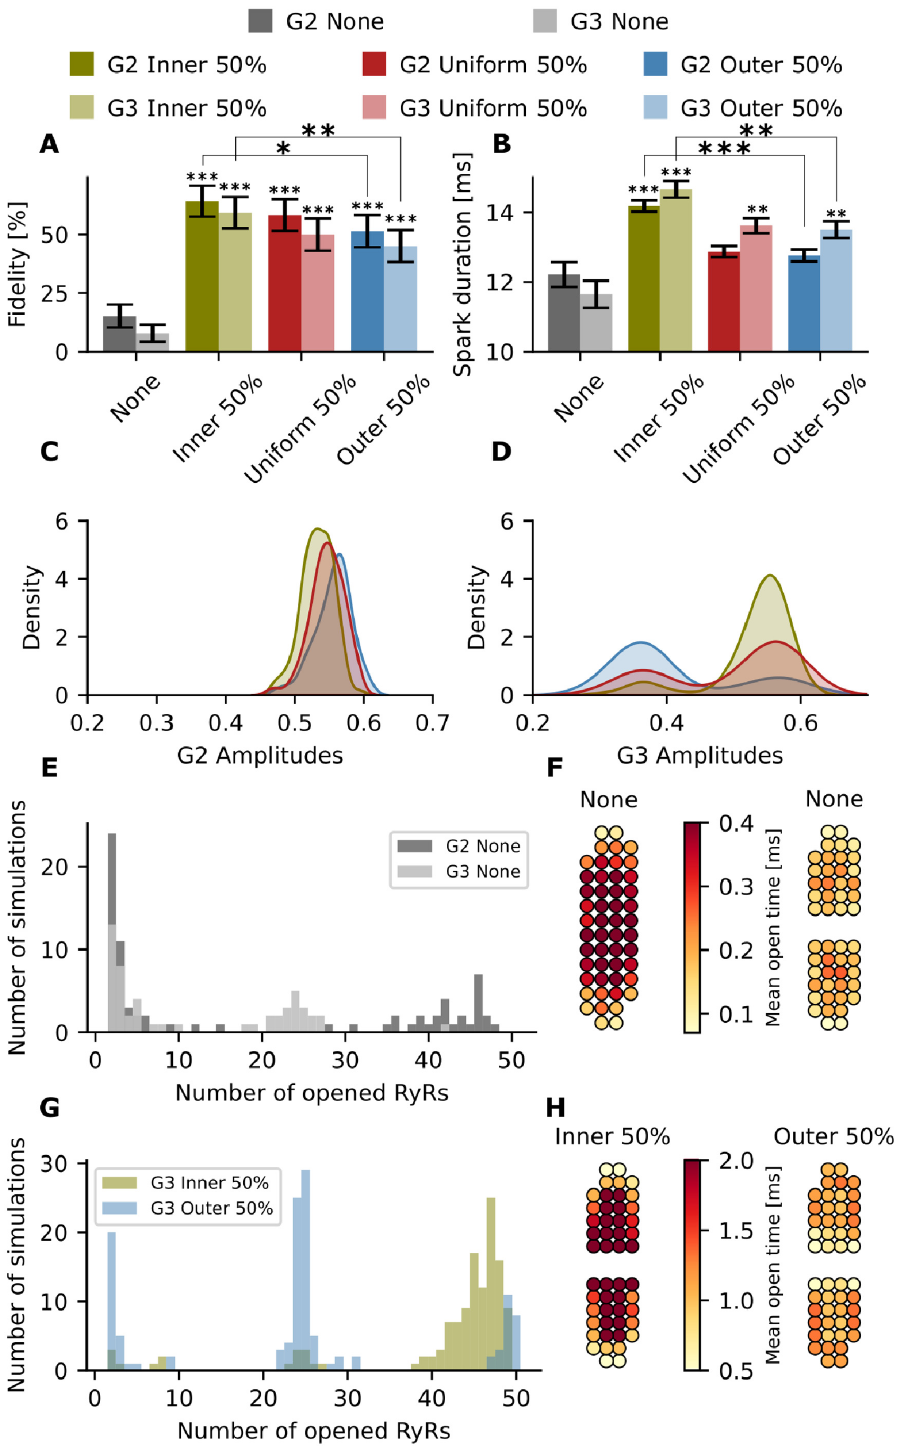
Fig 7. Effect of dispersed and phosphorylated RyR nanoclusters on spark properties. Green: inner; red: uniform; blue: outer; gray: no phosphorylation. Opaque colours: G2; translucent colours: G3. (A) Spark fidelity for none, inner, uniform, and outer phosphorylation in G2 and G3. The black bars indicate the 95% Agresti-Coull confidence interval. (B) Spark duration (mean ± standard error) for none, inner, uniform, and outer phosphorylation in G2 and G3. (C) Kernel density estimate plot of the amplitudes for the three phosphorylation patterns in G2. (D) Kernel